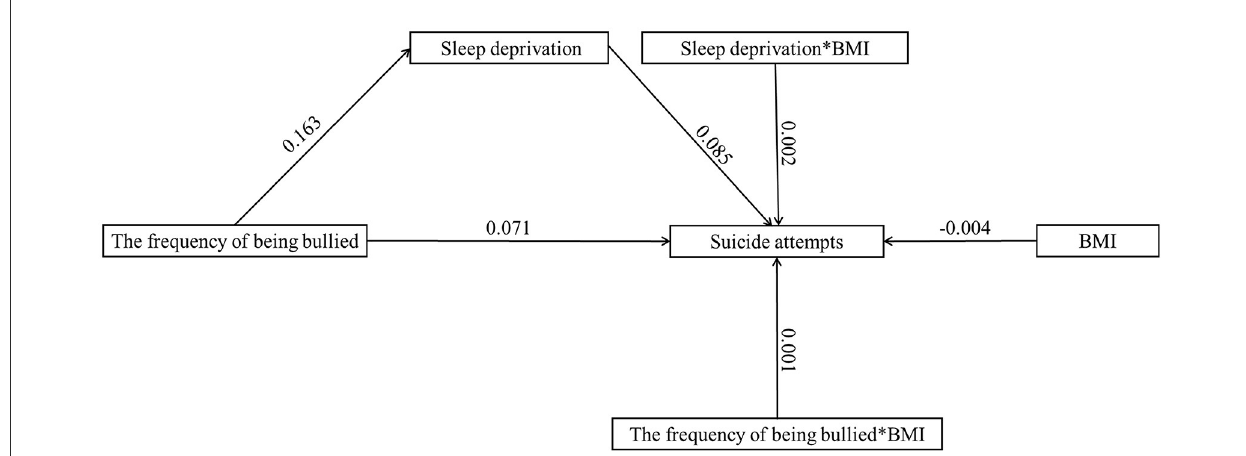
FIGURE1 The moderated mediation model with the frequency of being bullied ( n = 121,869).